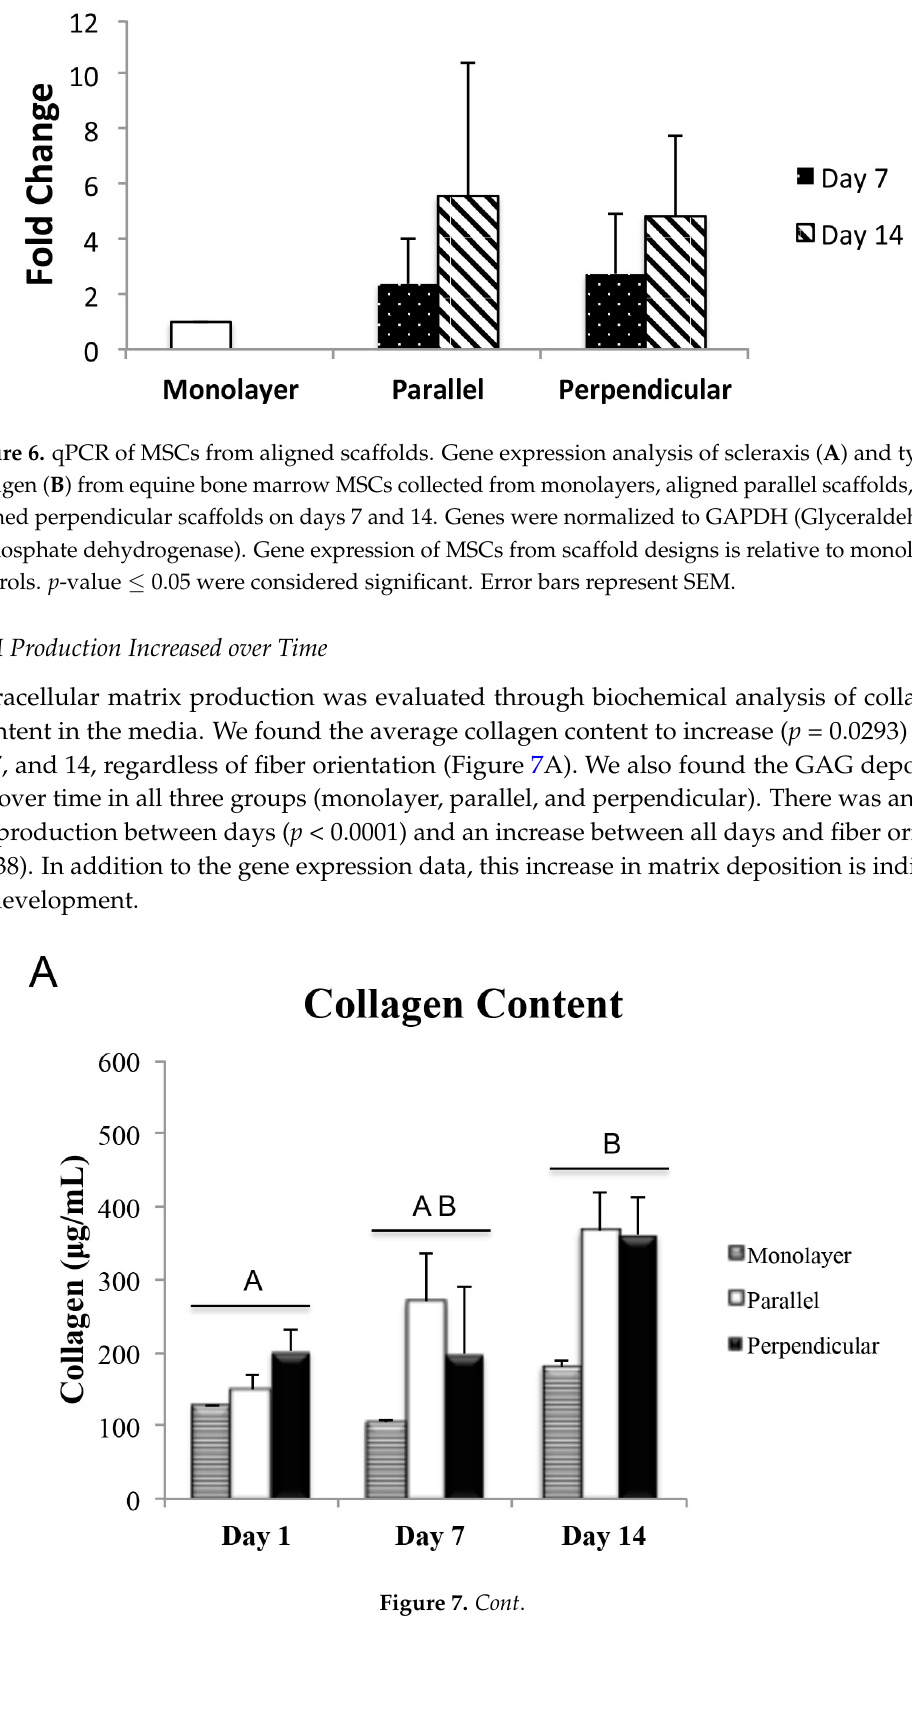
Figure 7. MSC production of the key matrix components. Collagen content quantification in media from cells in monolayer, aligned parallel scaffolds and aligned perpendicular scaffolds measured on days 1, 7, and 14 ( A ). p = 0.0038 for increased collagen production between days 1, 7, and 14, regardless of fiber orientation; GAG content quantification in media from cells in monolayer, aligned parallel scaffolds and aligned perpendicular scaffolds measured on days 1, 7, and 14 ( B ). p = 0.0038 for increased GAG production between all three days and fiber orientation. p -values ≤ 0.05 were considered significant. Groups not connected by the same letter are significantly different. Error bars represent SEM. 4. Discussion Aligned parallel and perpendicular suspended fiber networks were used to investigate cell response to microenvironmental cues of orientation and alignment; specifically tenogenic